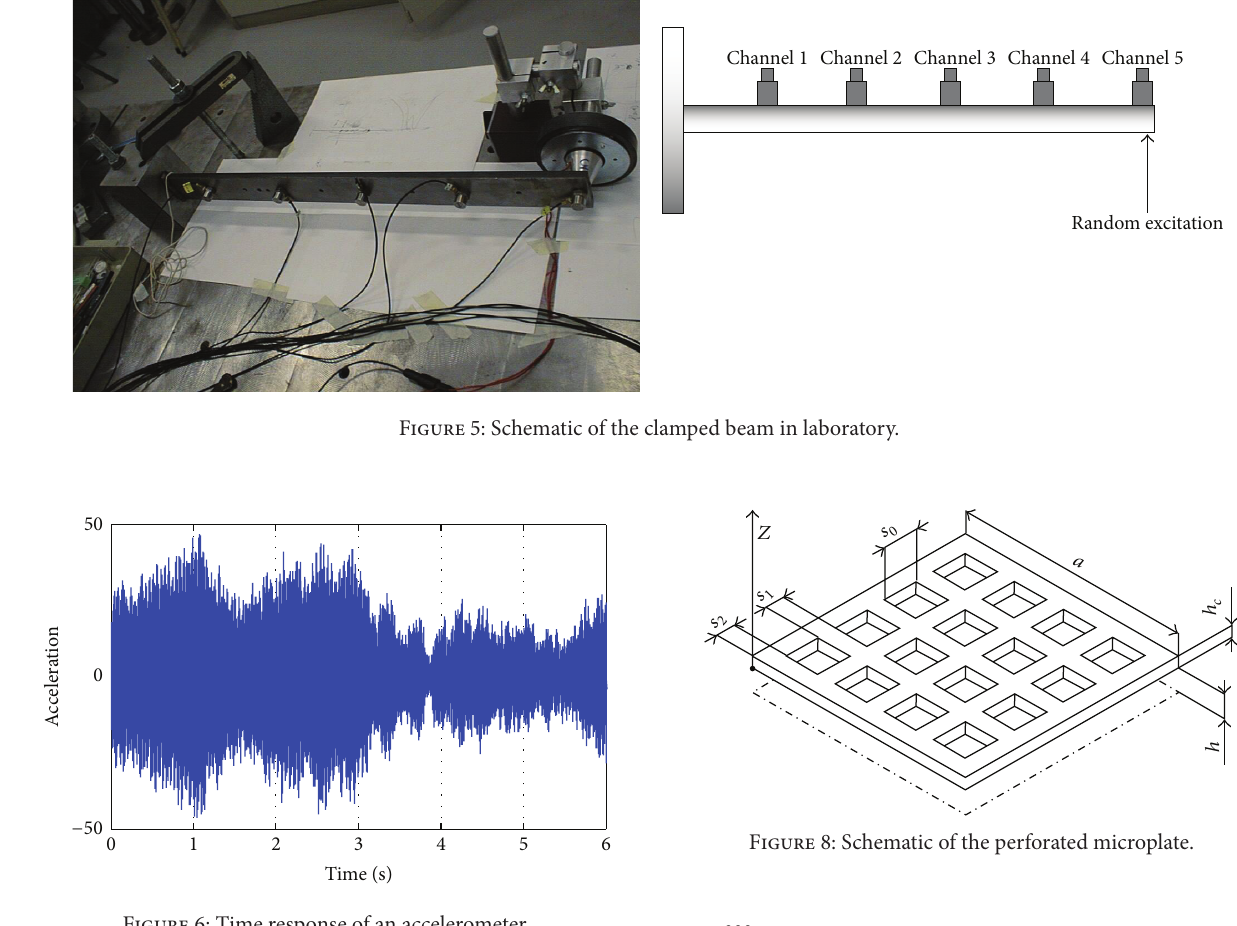
Figure 6: Time response of an accelerometer.